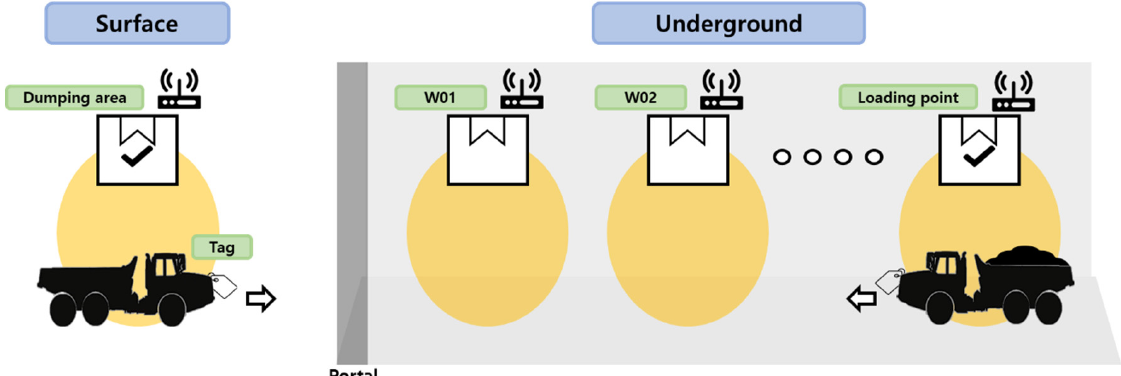
Figure 2. Diagram showing the sequence of wireless APs in the underground mine; W01 (W02): 1st (2nd) wireless access point (AP) installed underground.